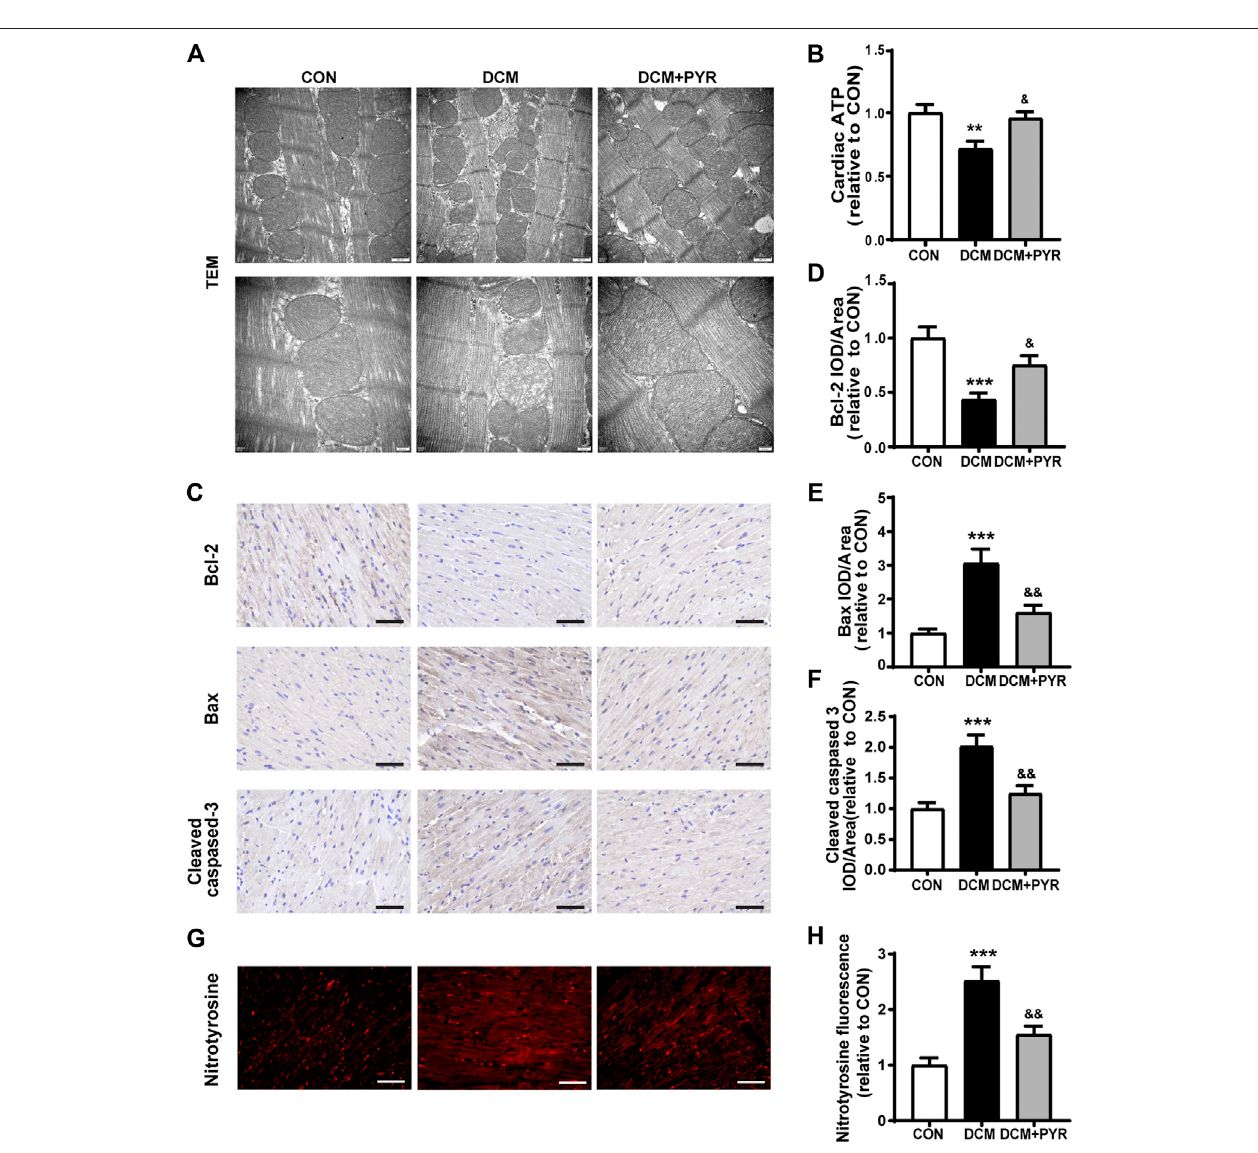
FIGURE7| Pyridostigminealleviatedcardiacmitochondrialdysfunctionindiabeticcardiomyopathymice. (A) Representativetransmissionelectronmicrographsof mitochondria in cardiac tissues; scale bar (cid:1) 500 nm (top) , 200 nm (bottom) . (B) ATP levels in cardiac tissues. (C – F) Immunohistochemical analysis of Bax, Bcl-2, and cleavedcaspase-3expressionincardiactissue;scalebar (cid:1) 50 μ m. (G – H) Immunohistochemicalanalysisofnitrotyrosineexpressionincardiactissue;scalebar (cid:1) 50 μ m. Data are expressed as the mean ± SEM. n (cid:1) 6 – 8. ** p < 0.01, *** p < 0.01, vs. CON; & p < 0.05, && p < 0.01, vs.